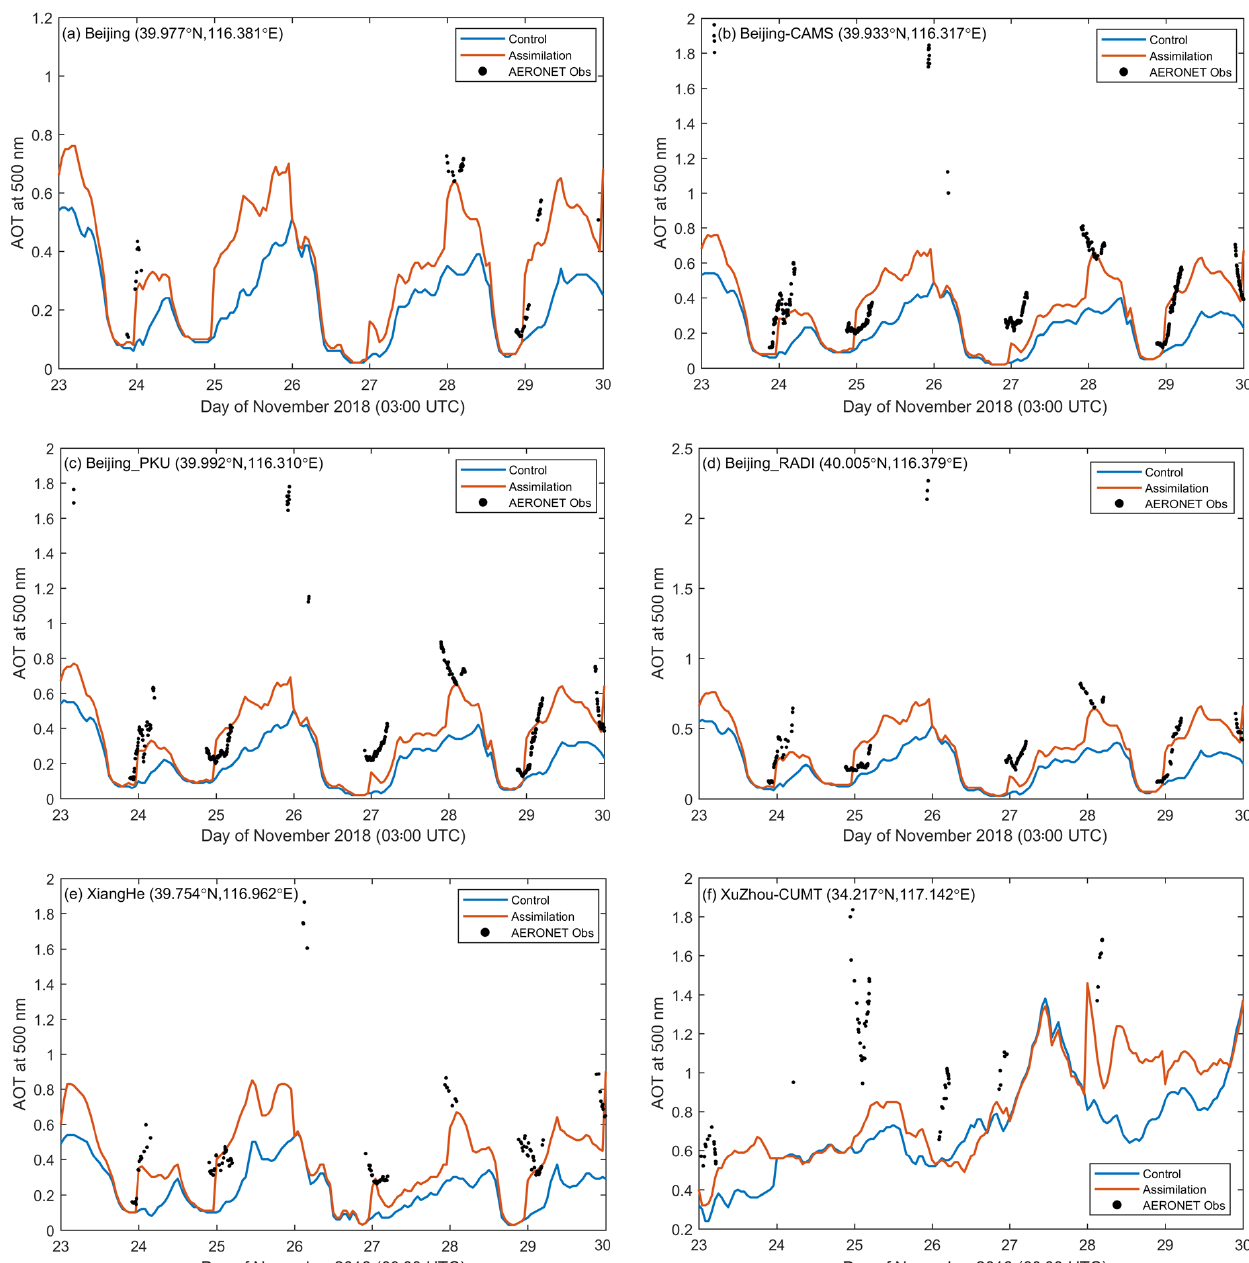
Figure 8. Time series of the simulated AOTs colocated in D02 and AERONET AOT observations at (a) Beijing, (b) Beijing-CAMS, (c) Bei- jing_ PKU, (d) Beijing_RADI, (e) XiangHe, and (f) Xuzhou-CUMT during the whole forecasting period. Both simulated AOTs and observed AOTs are at 500nm. The brown line is the control experiment, while the light blue line is the assimilation experiment, and the AERONET observations are represented by black dots, which are only available under clear-sky